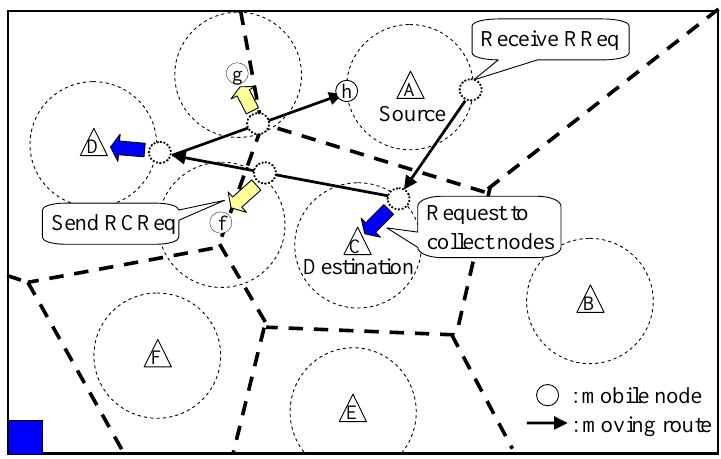
Figure 5. (a) Receiving RReq from the source